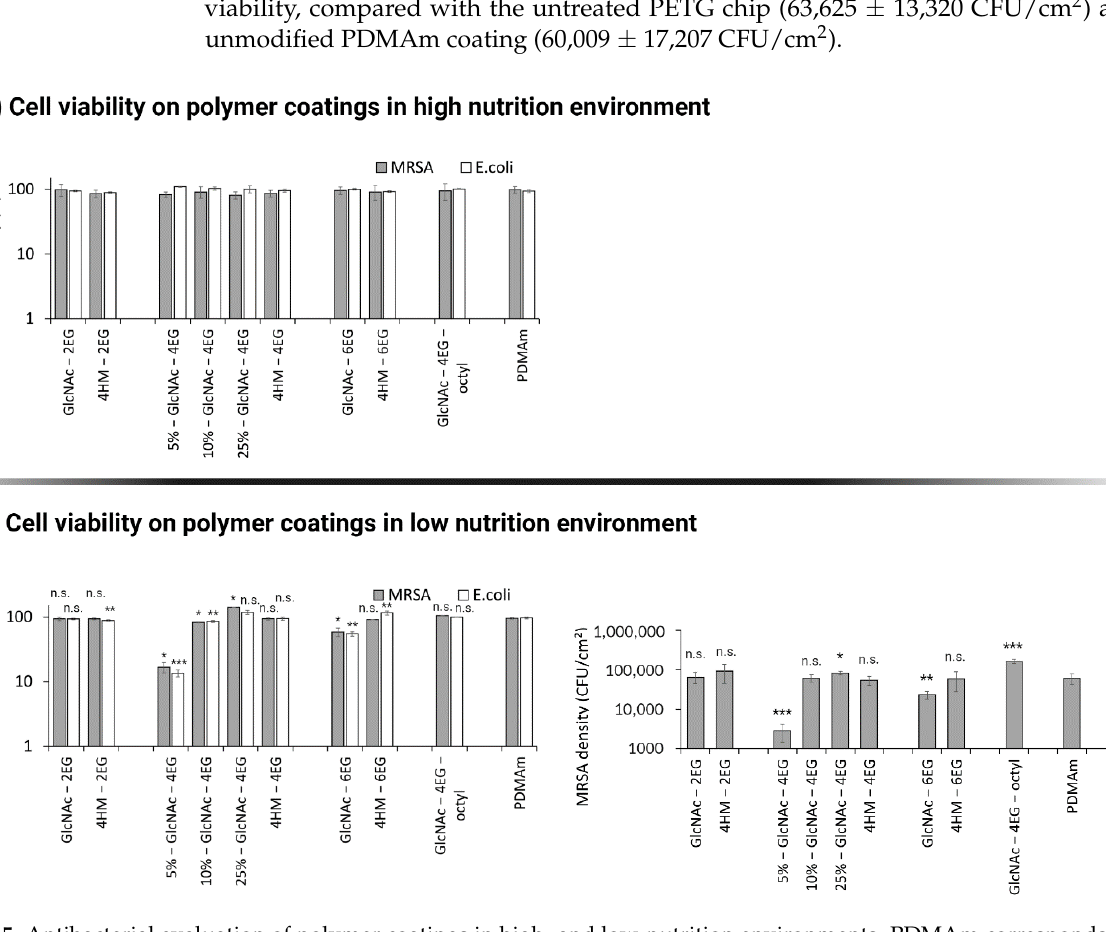
Figure 5. Antibacterial evaluation of polymer coatings in high- and low-nutrition environments. PDMAm corresponds to the unmodified acrylate coating. ( A ) Cell viability of Escherichia coli ( E. coli ) and multidrug-resistant Staphylococcus aureus (MRSA) on polymer coatings in the high-nutrition environment was assessed according to antibacterial assay (optical density, OD). Values are shown relative to that of the untreated sample. ( B ) Cell viability on polymer coatings in the low-nutrition environment was assessed for E. coli ( n = 4) and MRSA ( n = 2) according to antibacterial assay (optical density, OD, left graph) and in addition for MRSA ( n = 3) according to the more sensitive antibacterial assay (colony-forming units, CFU, right graph). Values are shown as mean ± SD. Significant changes were assessed by pairwise Student ´ s t -test (n.s., not significant; * p < 0.05; ** p < 0.01; *** p <